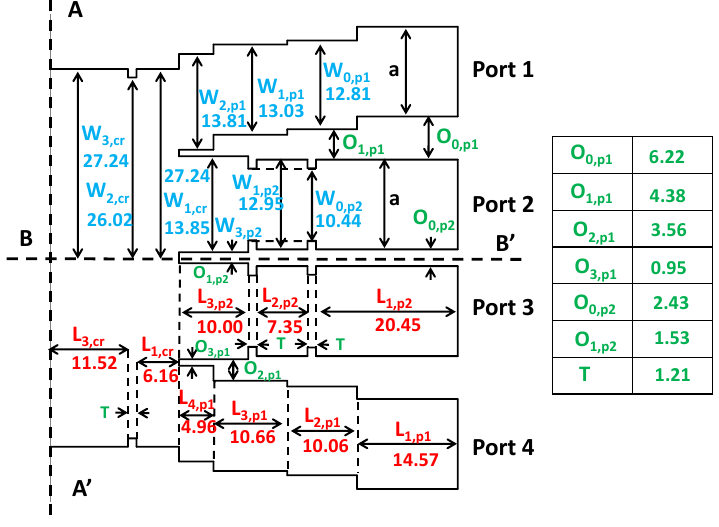
Figure 2. Optimized dimensions in the coupler (mm): Length (L ), Width (W), Offset (O), and Thickness (T) of the ports and the coupling region (showing one half of the structure).